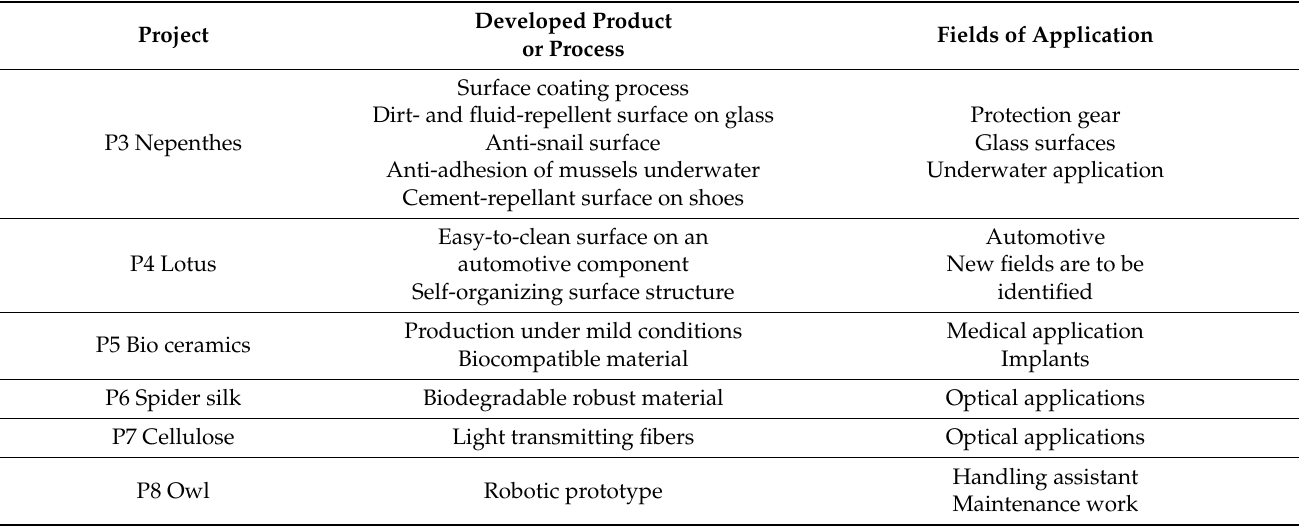
Table 4. Developments of the research projects with potential fields of